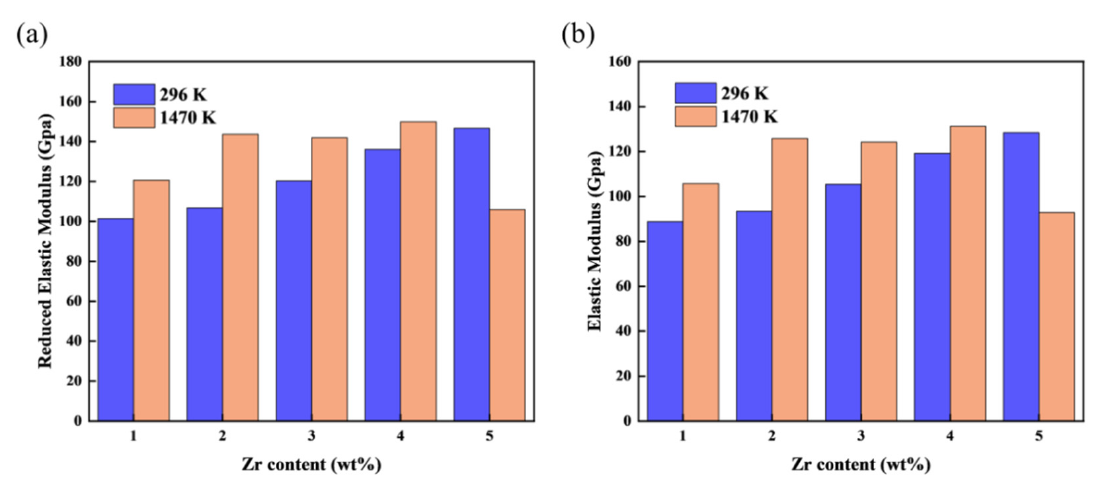
Figure 10. Comparison of reduced elastic modulus and elastic modulus between room temperature (296 K) and high temperature (1470 K) for different Zr content. ( a ) room temperature; ( b ) high tem- perature.